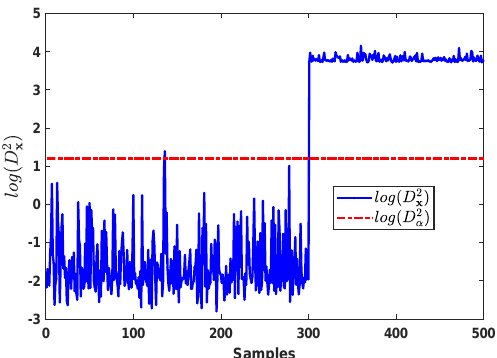
Figure 2. The fault detection results based on kNN for case 1 of numerical simulation.